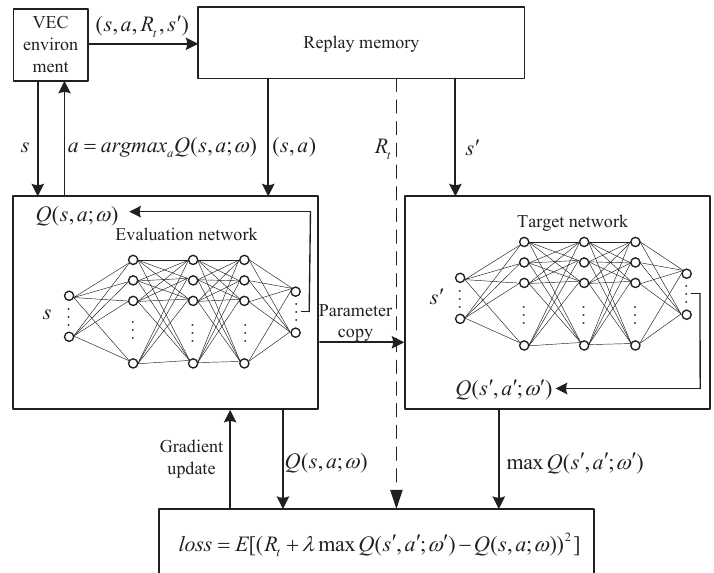
Figure 4. Structure of the MADQN-based task scheduling